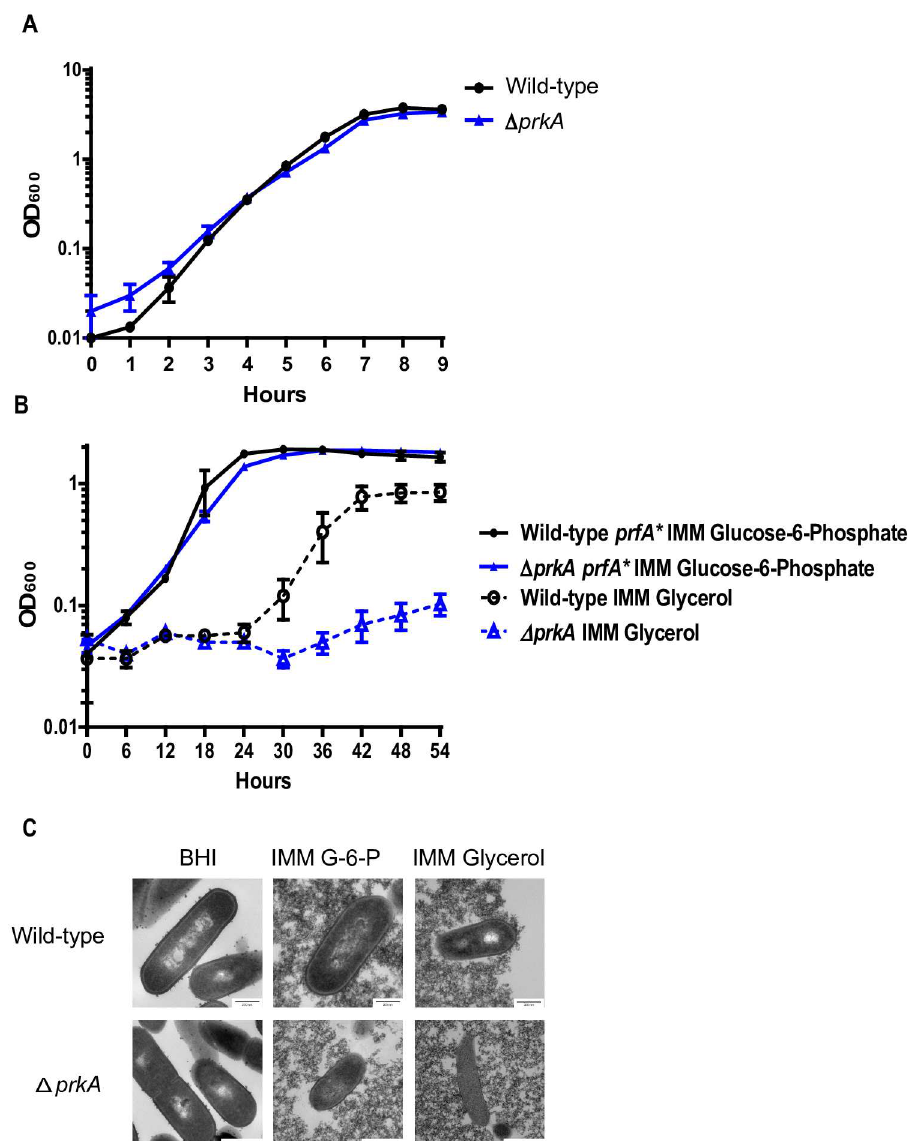
Fig 1. The Δ prkA mutant has altered growth and morphology in minimal media with glycerol as the primary carbon source. (A) Growth of the Δ prkA mutant in BHI, (B) or in Improved Minimal Media (IMM) with glucose-6-phosphate(filled symbols and solid lines) or glycerol (open symbols and dashed lines) as the sole carbon source. Data are averages of three biologicalreplicatesand error bars represent standard deviationof the mean. (C) Morphologyof wild-typeand the Δ prkA mutant in BHI, IMM Glucose-6-phosphate, and IMM Glycerol at OD 0.5 (BHI) or 6 hours post